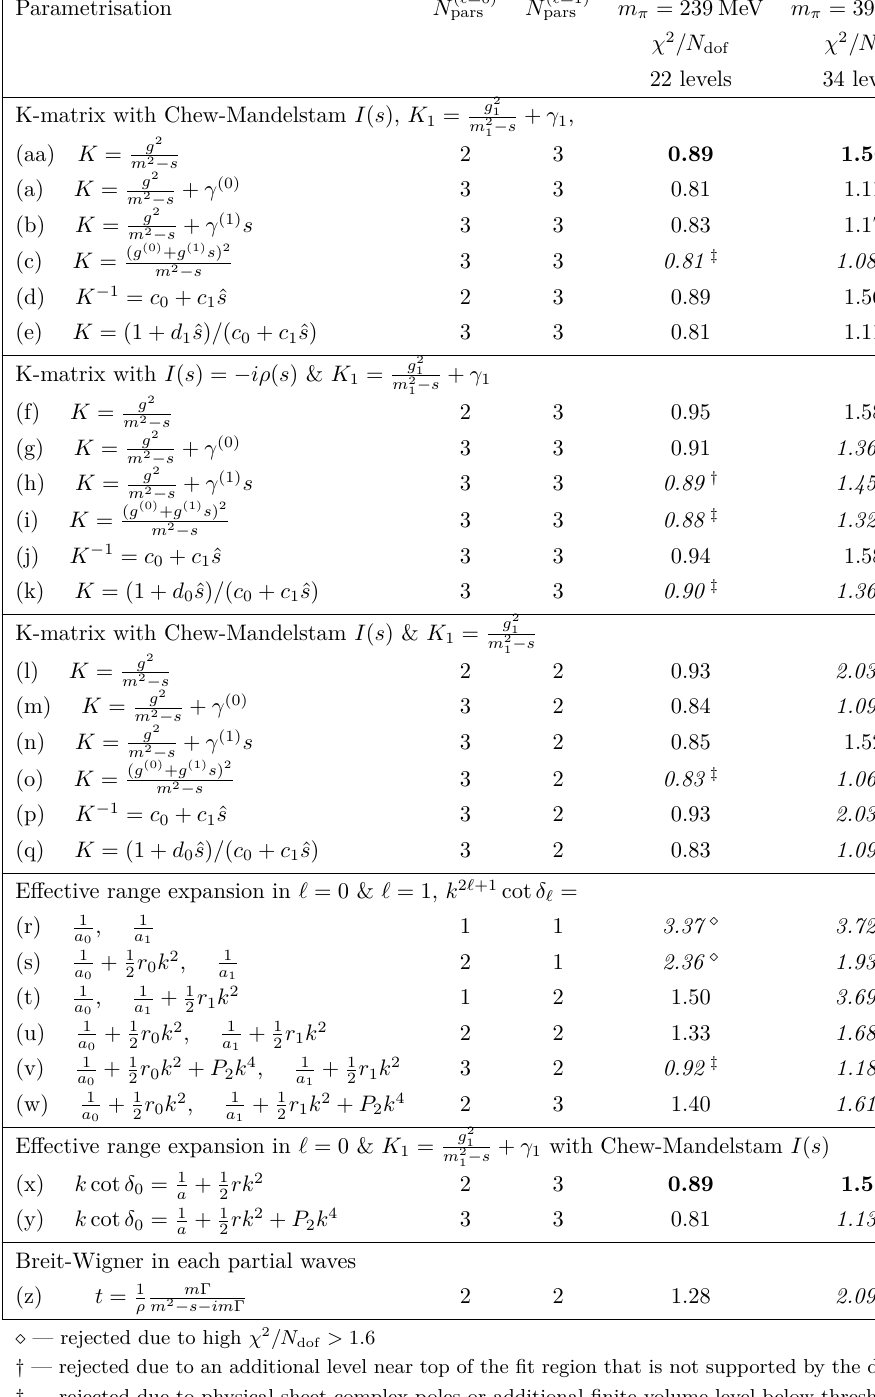
Table 4 . A selection of the S and P -wave parametrisations used for elastic I = 0 DK scattering. N ( ‘ ) pars indicates the number of free parameters for partial wave ‘ . The χ 2 /N dof in bold indicate the reference and effective range fits described in the text. Parametrisations with χ 2 /N dof in italics are not considered an acceptable description of the data for the reason given in the